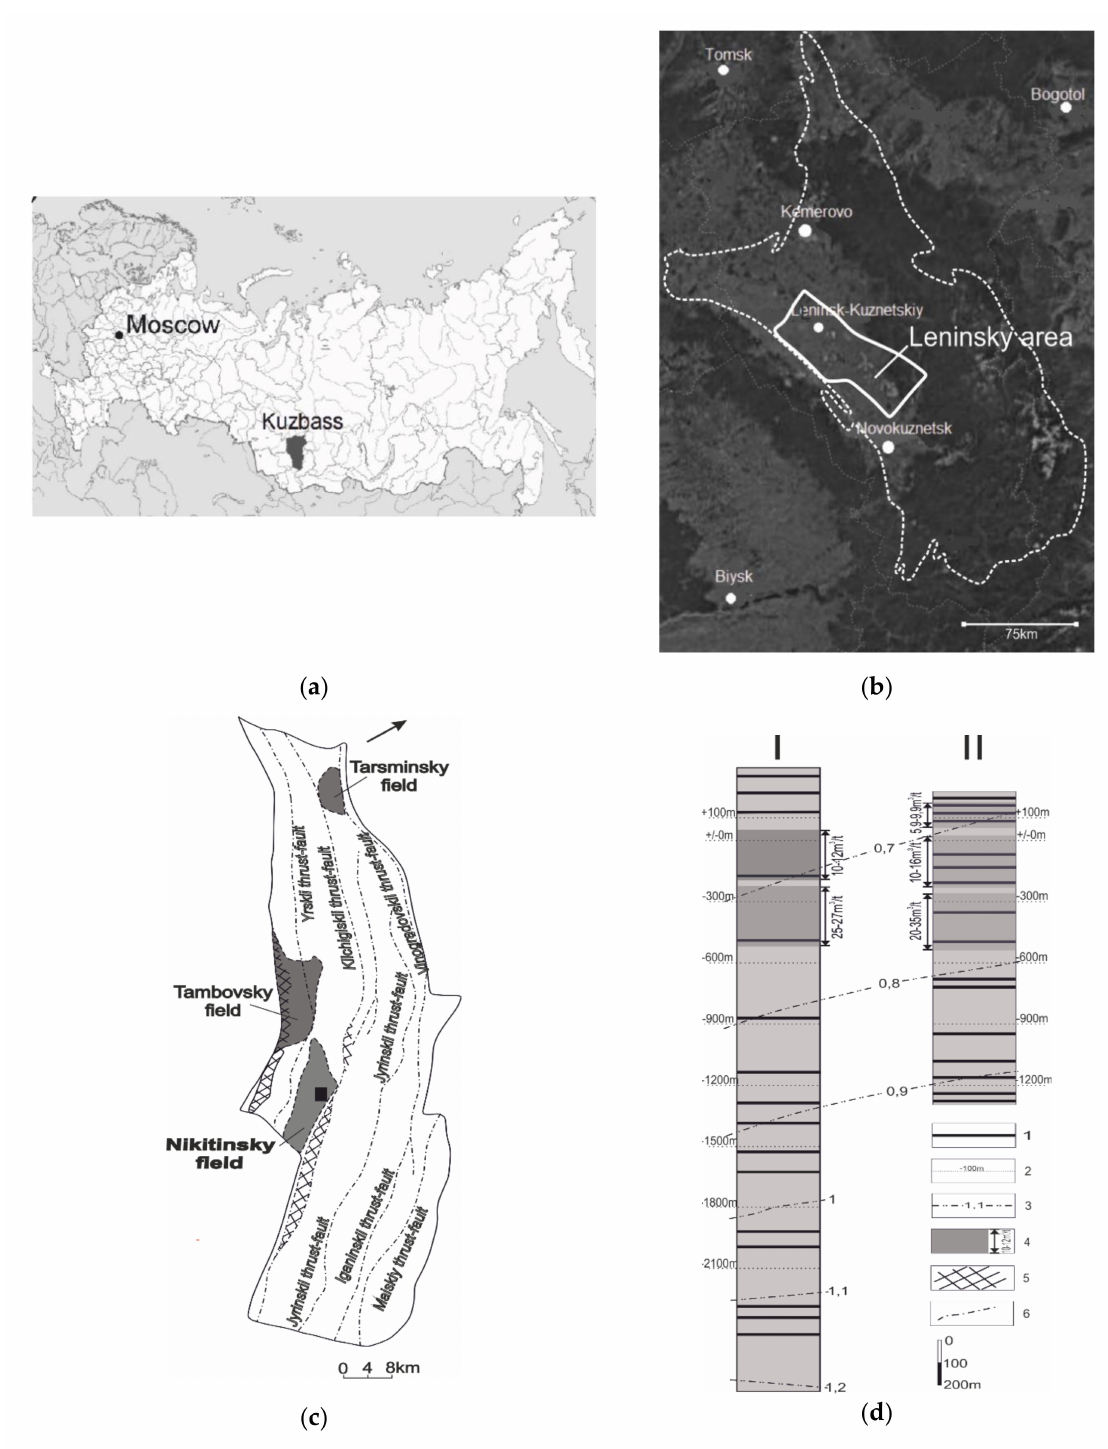
Figure 1. Locations of the Nikitinsky, Tambovsky, and Tarsminsky fields in the Leninsky area, Kuzbass: ( a ) Kuzbass in Russia. ( b ) Location of the Leninsky area. ( c ) Locations of the fields of the coking coals and the main thrust faults in the Leninsky area. Black rectangle-the S.D. Tihov mine. ( d ) Significant coal seams of the Nikitinsky (II) and Tambovsky (I) fields. Legend: 1-coal seam; 2-horizon; 3-coal vitrinite reflectance; 4-gas content of coals and rocks in the certain depth interval; 5-rock crushing zones; 6-main thrust faults in the